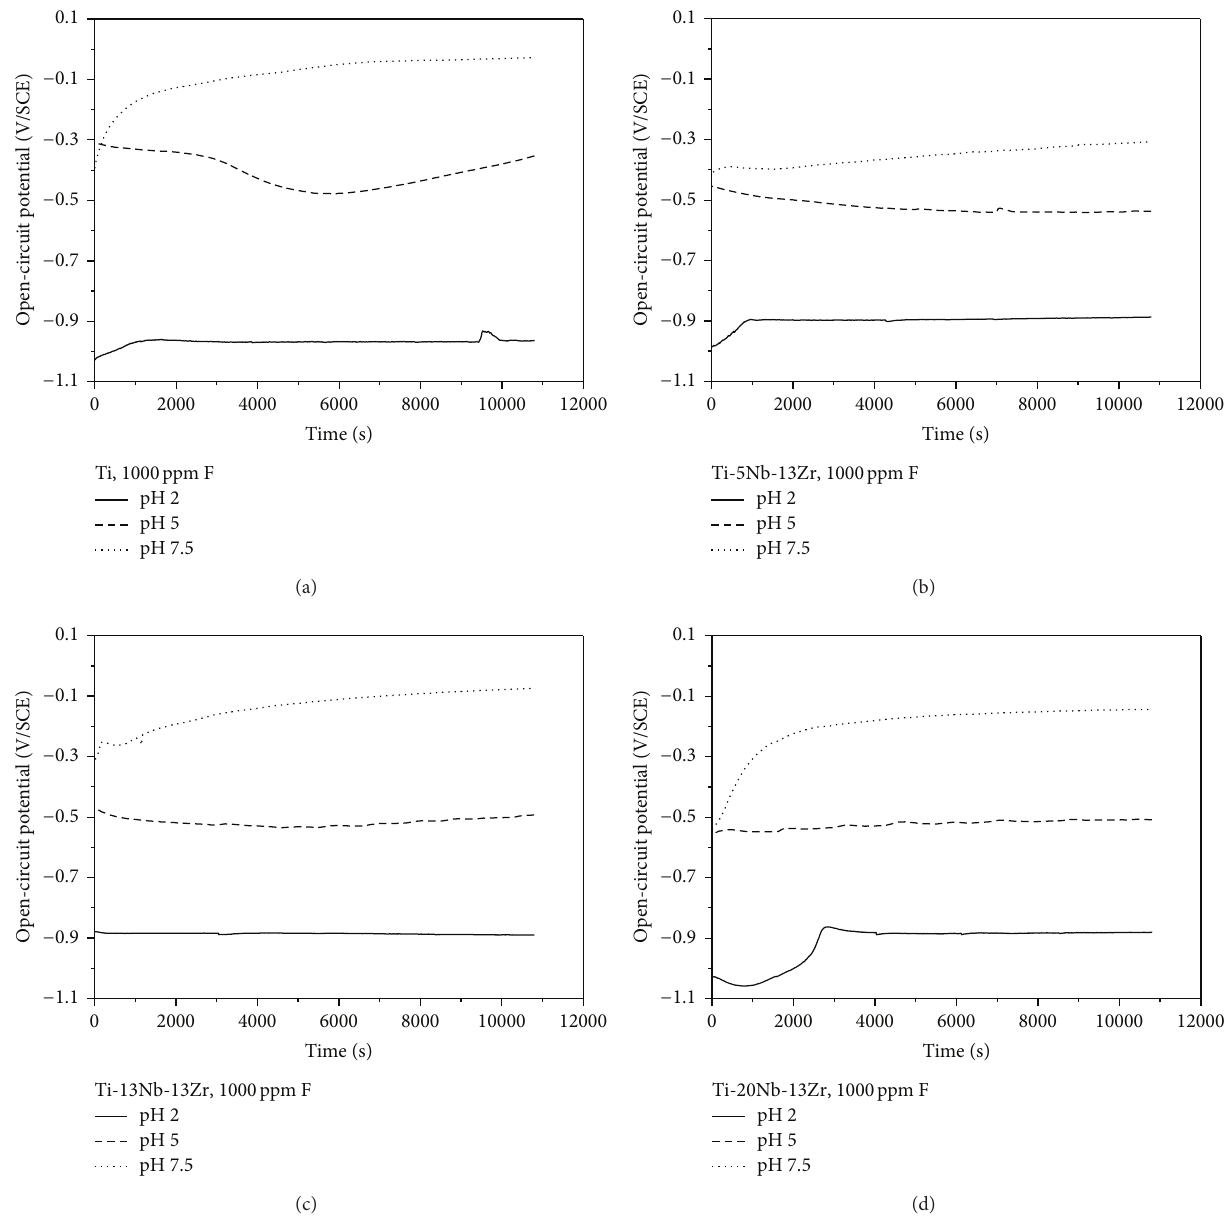
Figure 5: Variation of OCP with exposure time for (a) CP-Ti, (b) Ti-5Nb-13Zr, (c) Ti-13Nb-13Zr, and (d) Ti-20Nb-13Zr in Ringer’s solution of pH 2, 5, and 7.5 containing 1000ppm F at 37 ∘